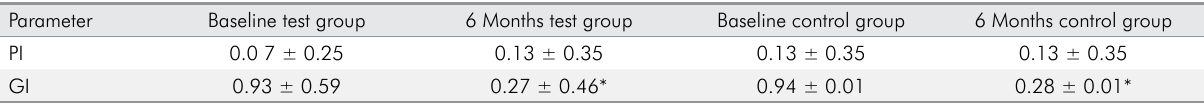
Table 3. Plaque index and gingival index scores in both groups.